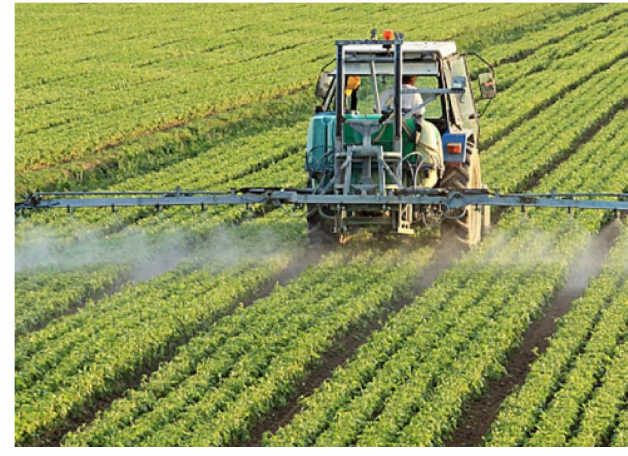
Figure 9. Tractor-mounted boom sprayer [50].